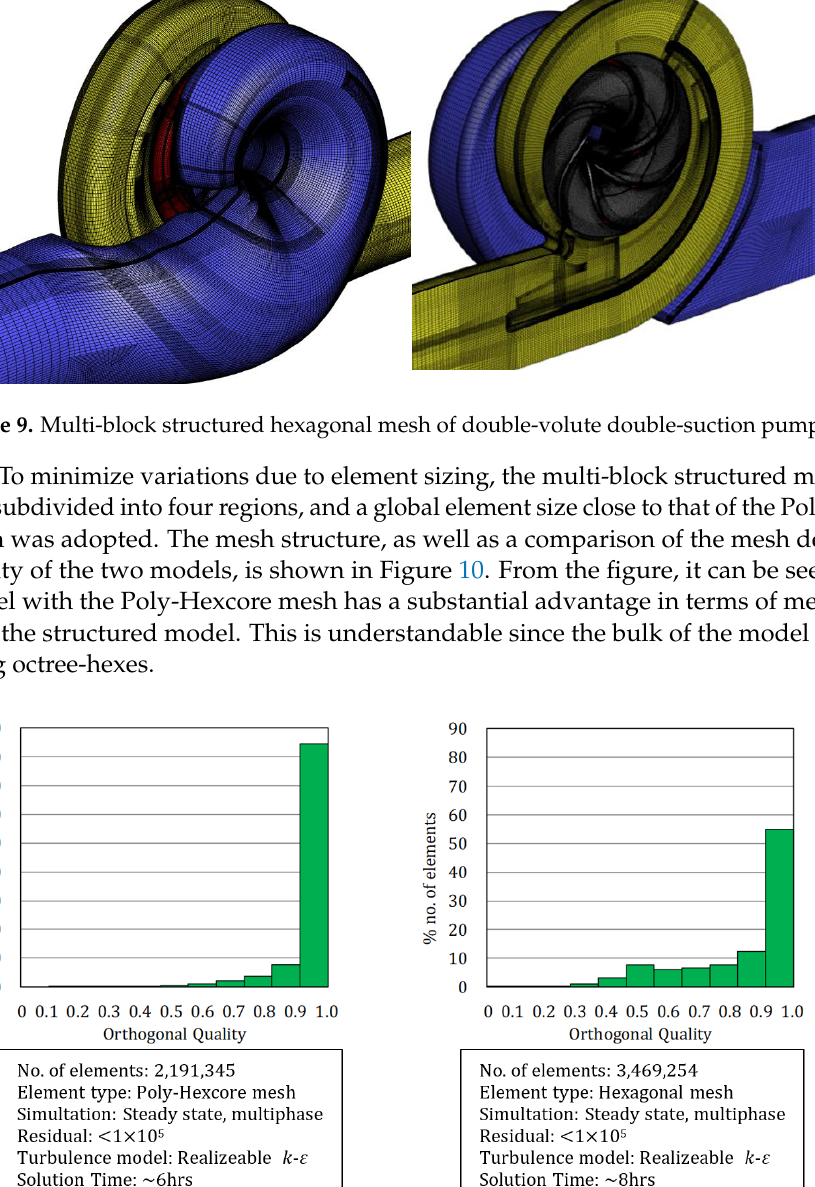
Figure 8. Pump Performance Curve based on CFD calculations and Manufacturer ’ s data.